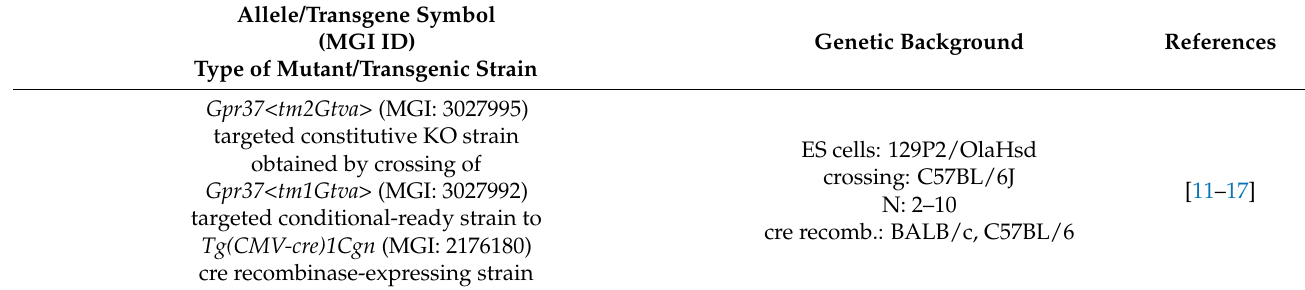
Table 1. Mouse Gpr37 mutant